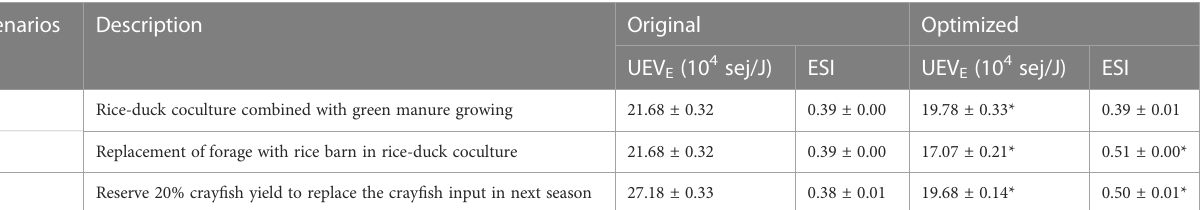
TABLE 6 Scenarios description and simulation